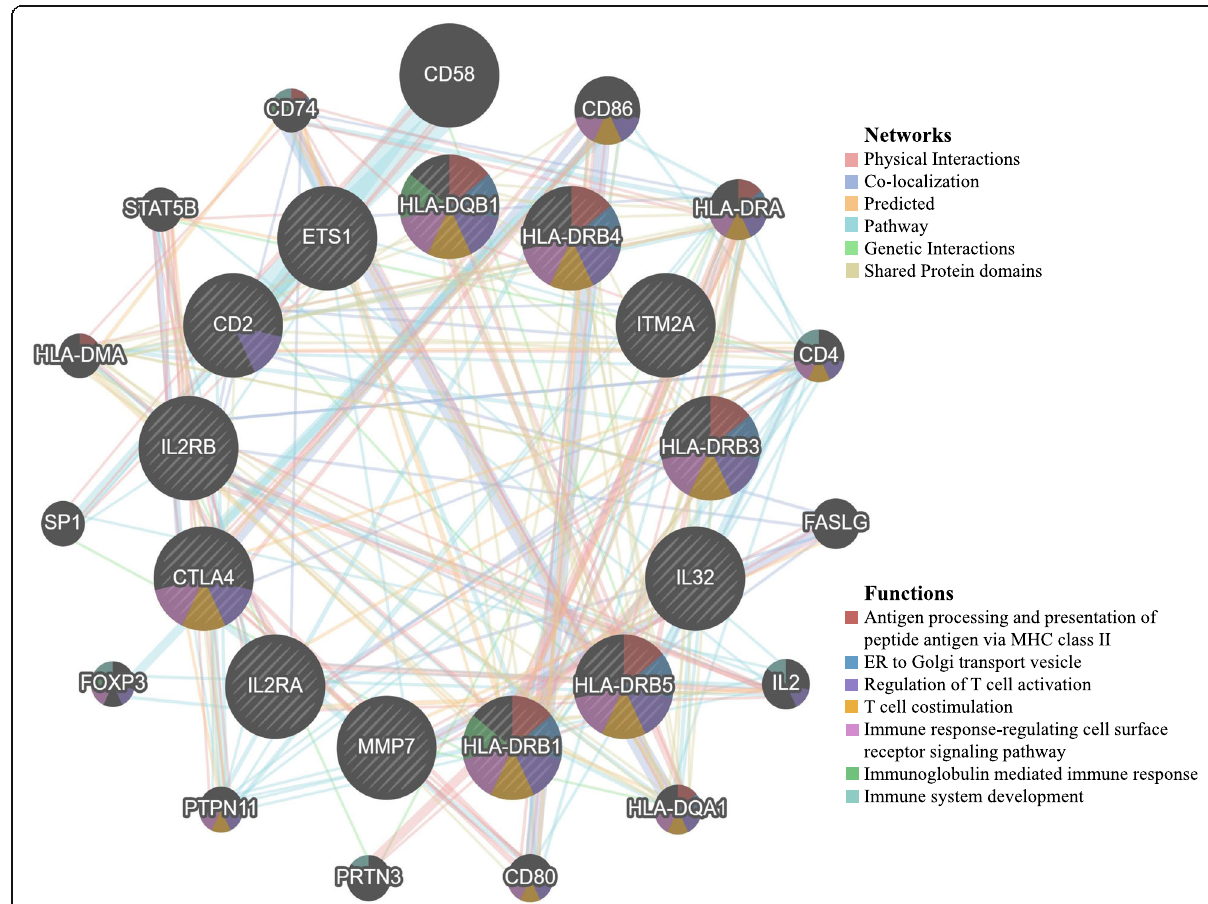
Fig. 3 Construction of a gene-gene network using the most significantly downregulated genes (fold change < 0.6 and p -value < 0.05). Black circles with white stripes (inside circle) indicate genes that were entered as query terms, while black circles indicate the associated genes. The size of the circle corresponds with the number of correlations with other genes in the